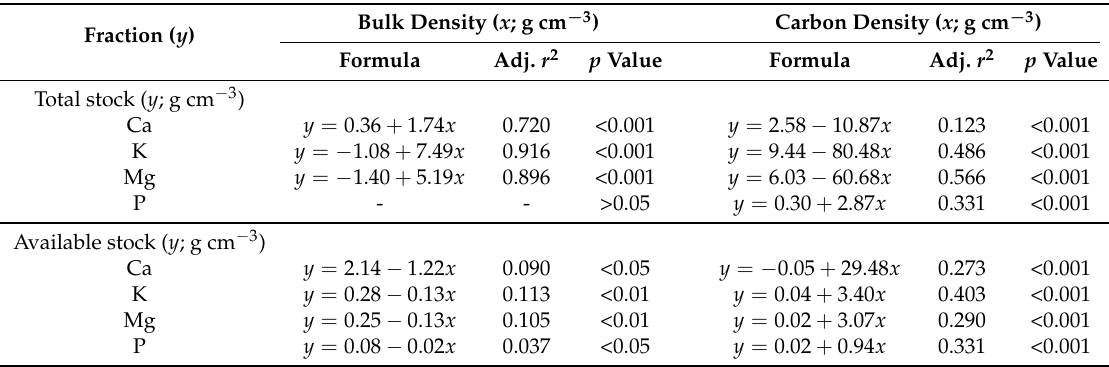
Table 4. Linear regressions between total and available nutrient densities by volume ( y ) and both bulk and C density by volume ( x ) for the mineral soil.